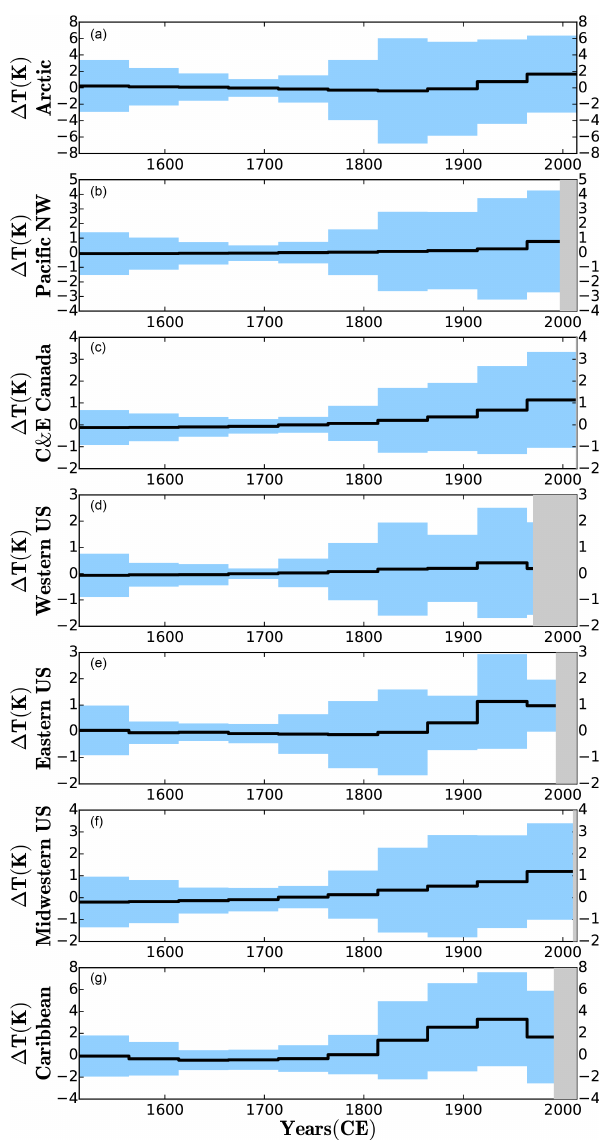
Figure 7. Mean GST histories (black), the blue shaded areas repre- sent the 95% confidence interval associated with the climate vari- ability of each area. Regional mean temperatures are shown until the year of measurement of the most recent thermal profile in each region. (a) Arctic (78 sites), (b) Pacific northwest (78 sites), (c) cen- tral and eastern Canada (220 sites), (d) western US (21 sites), (e) eastern US (9 sites), (f) midwestern US (100 sites), (g) Caribbean (4